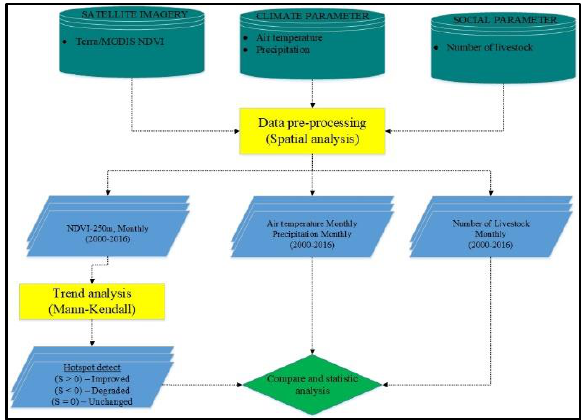
Figure 2. Flowchart of hotspot of land degradation for study area